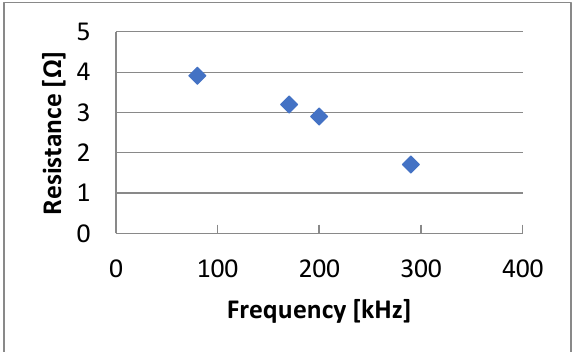
Figure 11. The dependence of resistance changes on the frequency of the laser beam.